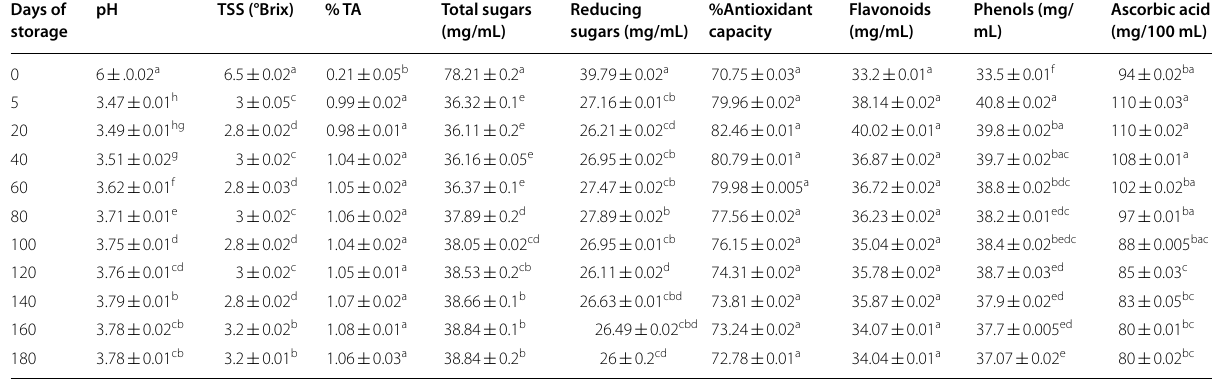
TA titrable acidity, TSS total soluble solids All observations are average of triplicates Means with the same letter are not significantly